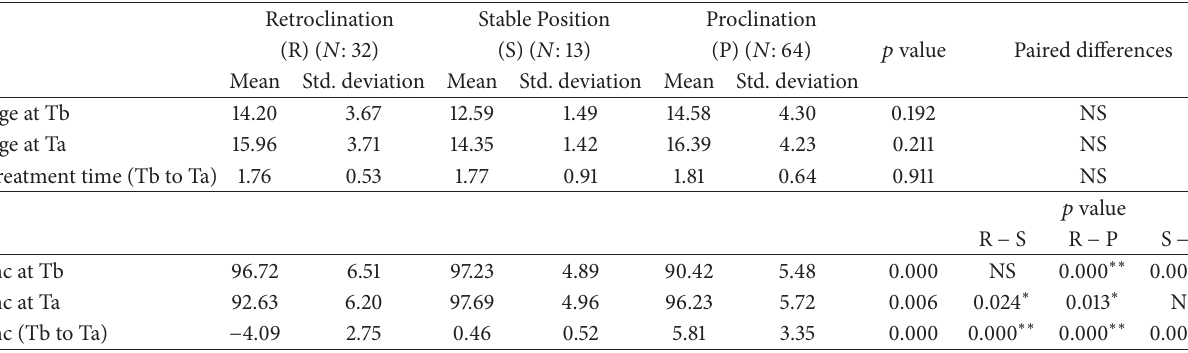
Table 2: Characteristics of the inclination groups.